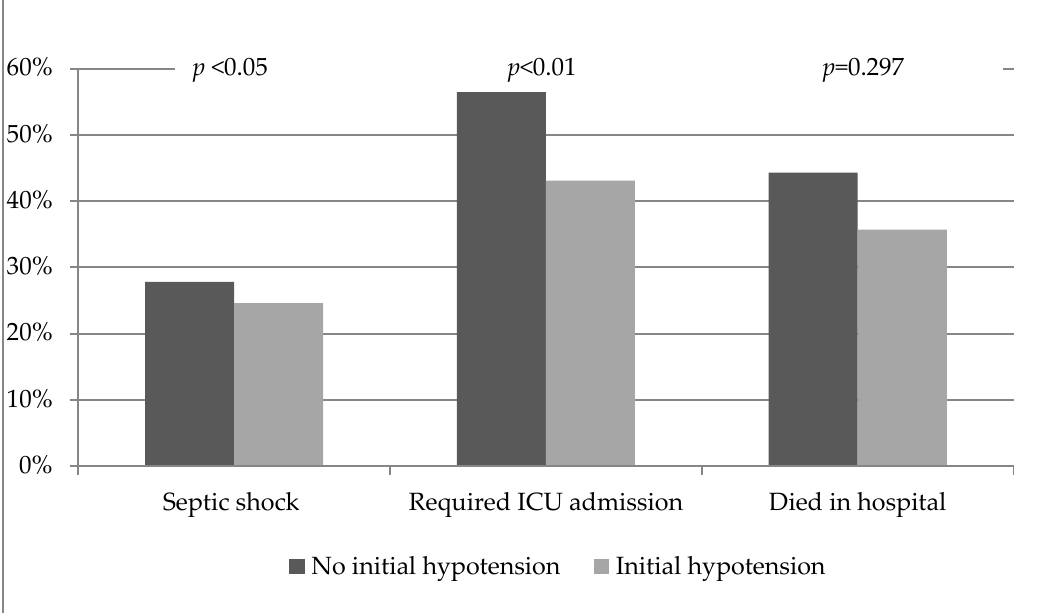
Figure 3. Differences in clinical evolution and outcomes between patients, with community-onset severe sepsis, that initially presented with hypotension and those that initially presented without hypotension.